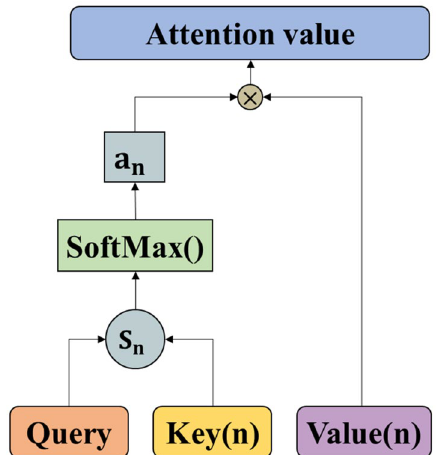
Figure 4. Attention calculation